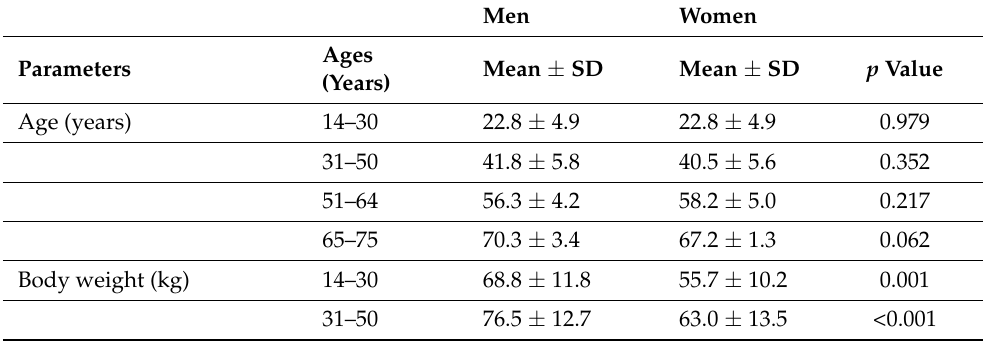
Table 2. Demographic and anthropometric characteristics of patients with FSHD according to